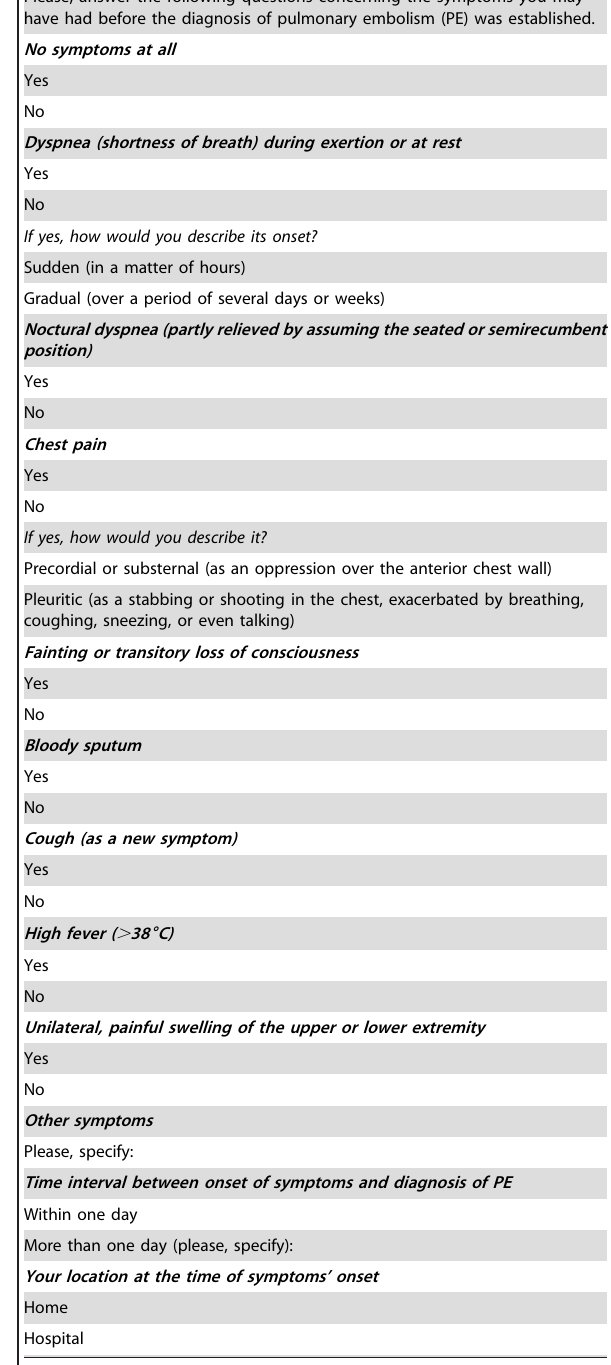
Table 1. Standardized